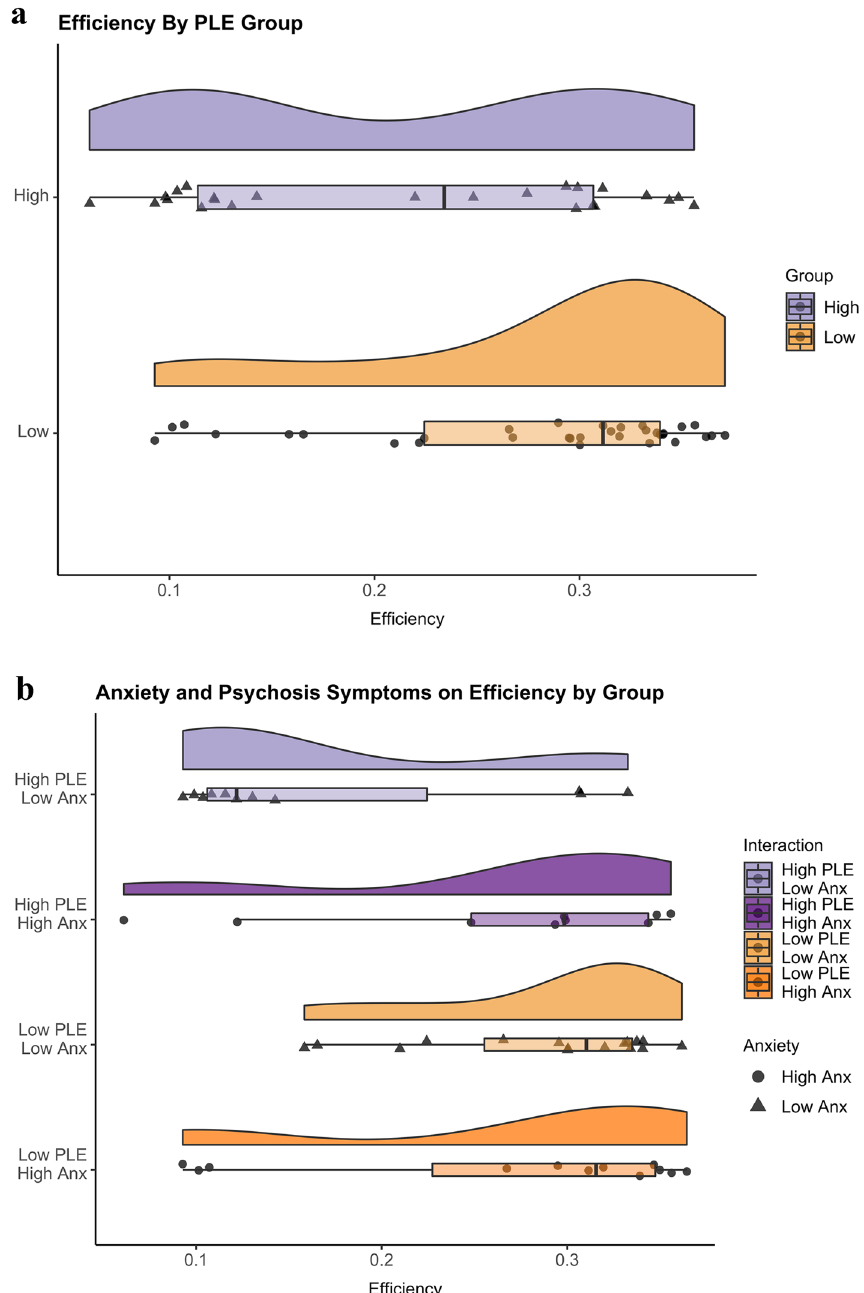
Figure 3. ( a ) Efficiency by PLE group. The high-PLE group made significantly less efficient responses compared to the low-PLE group. PLE psychotic-like experiences. ( b ) Efficiency relates to anxiety symptoms in the high- PLE group. Individuals with greater levels of anxiety in the high-PLE group made efficient responses comparable to those with low-PLE. Note that the PLE groups were divided into different high/low anxiety groups for illustrative purposes only and all analyses treated anxiety symptoms continuously. Anx anxiety symptoms, PLE psychotic-like